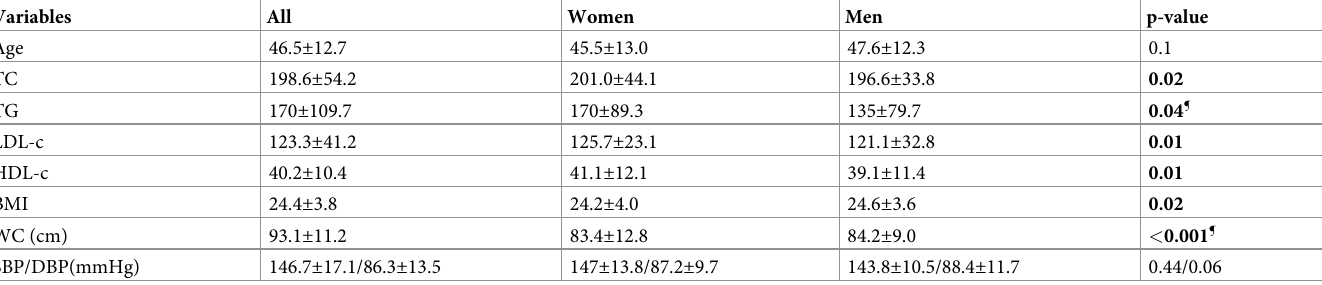
Table 3. The mean/median values of serum lipid profile and other risk factors stratified by gender (n = 384). Variables